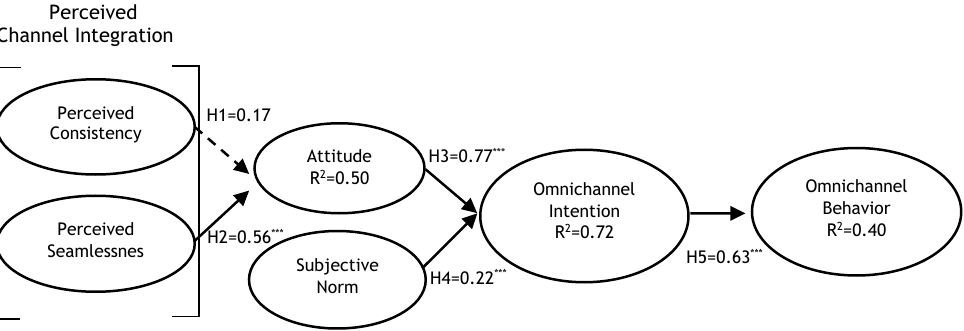
Figure 2. Results of research model and